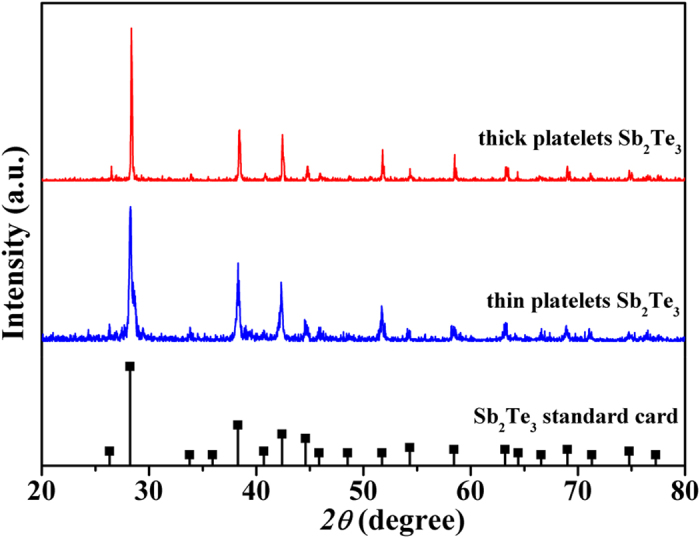
XRD patterns of Sb2Te3 nanostructured powder with different thickness.